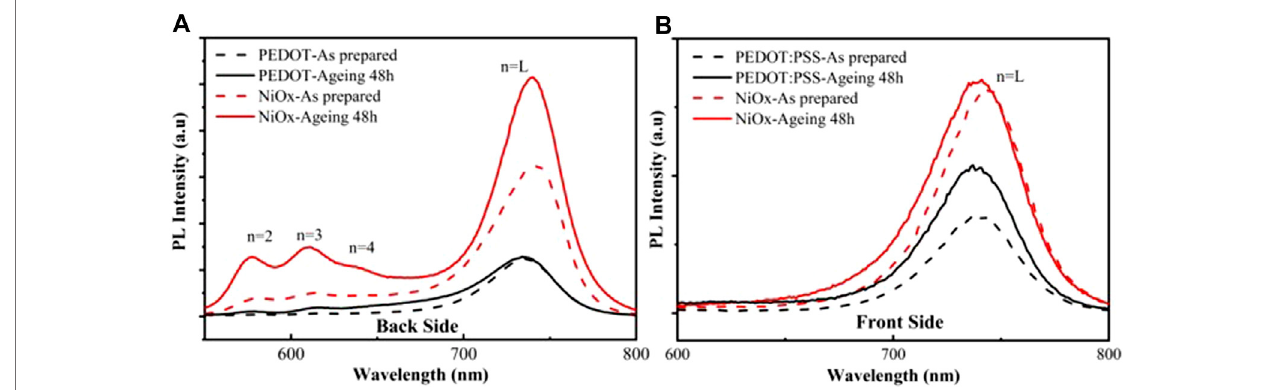
FIGURE 4 | Steady-state PL spectra of fi lms before ageing. (A) Back excitation and (B) front excitation.